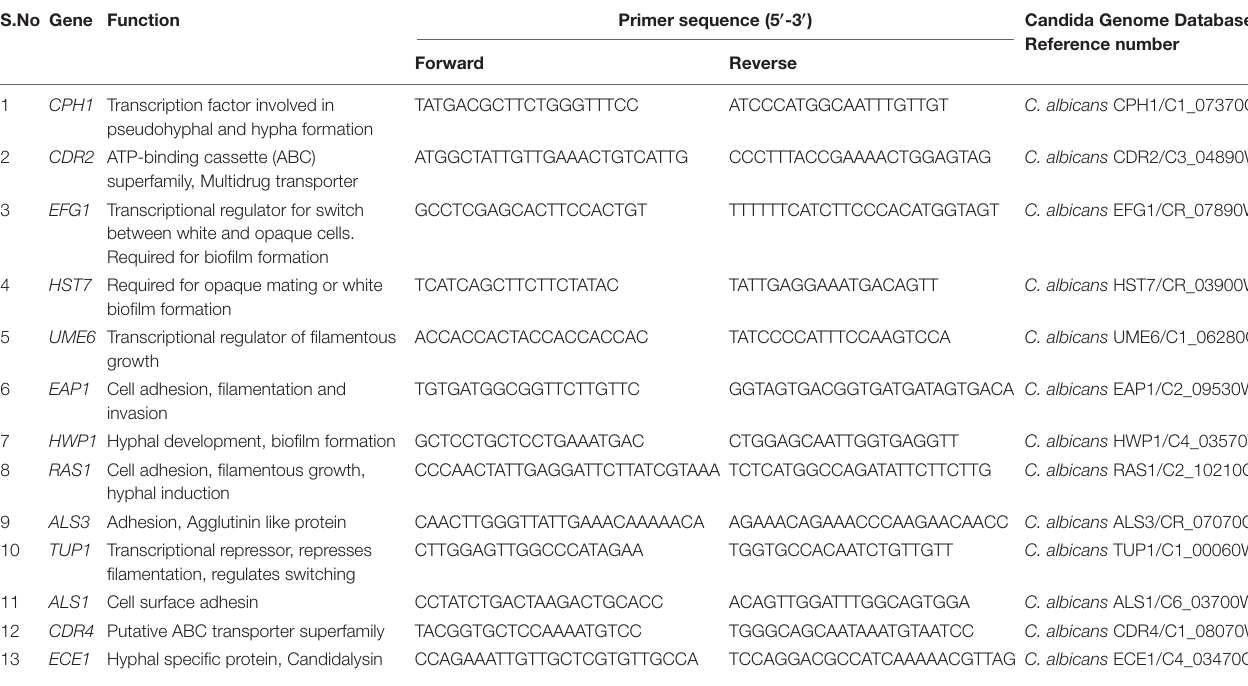
TABLE 1 | List of genes, their function in pathogenicity of C. albicans , and primer sequences used in the study. S.No Gene